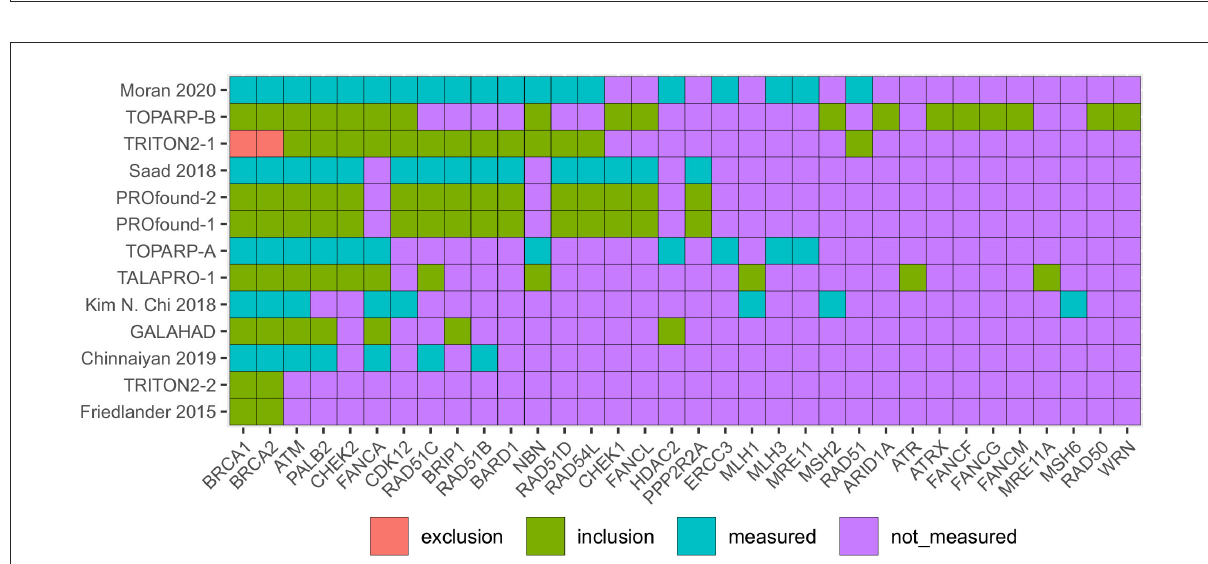
FIGURE3 Heatmap identifying the DRD and HRD biomarkers measured in included mCRPC clinical trials. Red boxes identify biomarkers that were used to exclude patients, green used for including patients, blue biomarkers were measured but not used for eligibility. Purple biomarkers were not measured. Trials in red (on left) provide patient level data in figures or